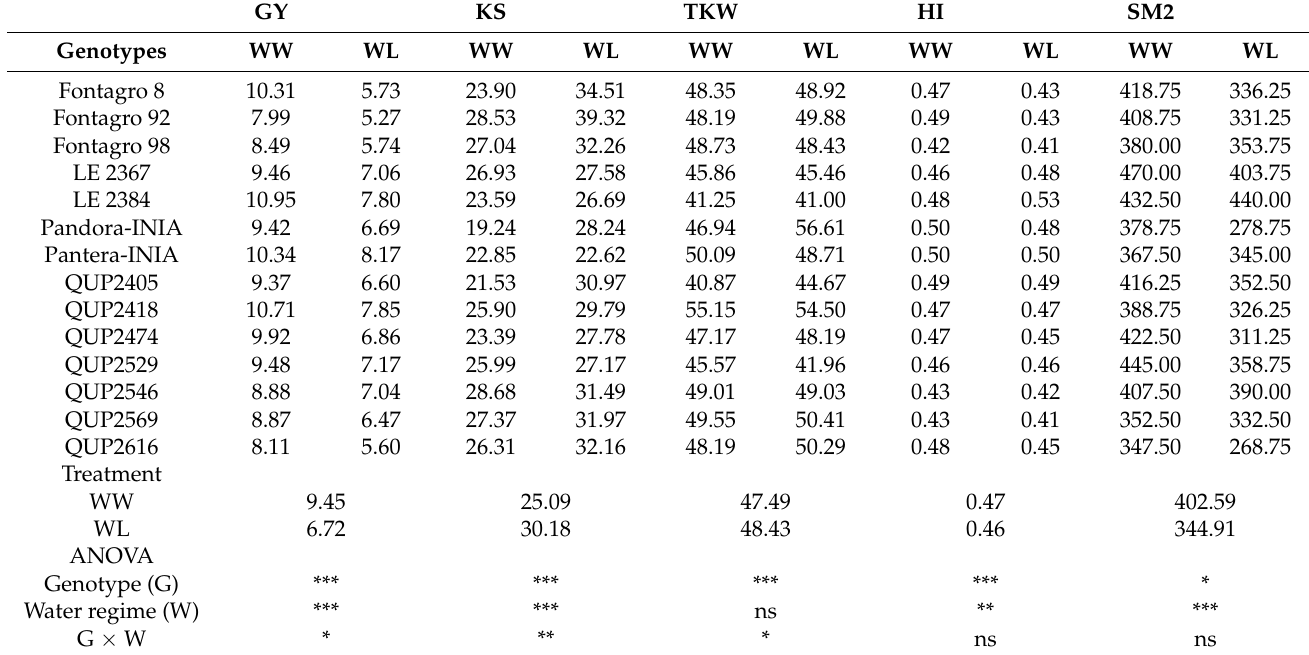
Table 5. Mean values of grain yield (GY; t ha − 1 ), number of kernels per spike (KS), thousand-kernel weight (TKW; g), harvest index (HI) and number of spikes per square meter (SM2) for fourteen genotypes grown under water-limited (WL) and well-watered (WW) regimes in field conditions. Significance levels for the analysis of variance (ANOVA) are also